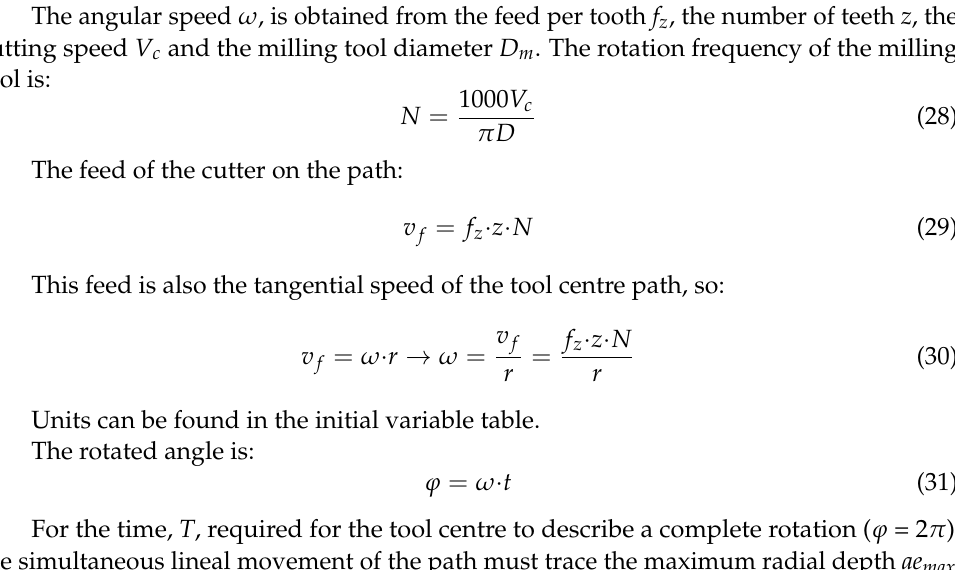
Figure 12. Milling time